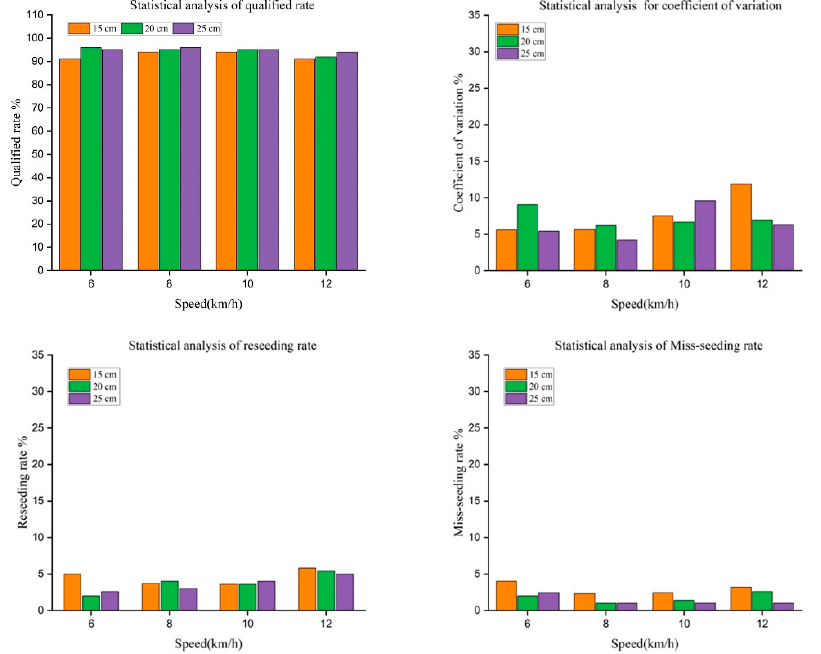
Figure 14. Statistical analysis of the performance index data. Table 4. Correlation analysis between factors and performance indicators.